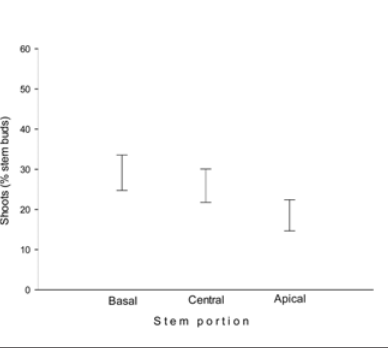
Figure 3. Shoot emergence from different stem portions of plants propagated by micropropagation (A) and by rhizomes (B) in summer period (segments in the upper graph part indicate the differentiation period between curves).